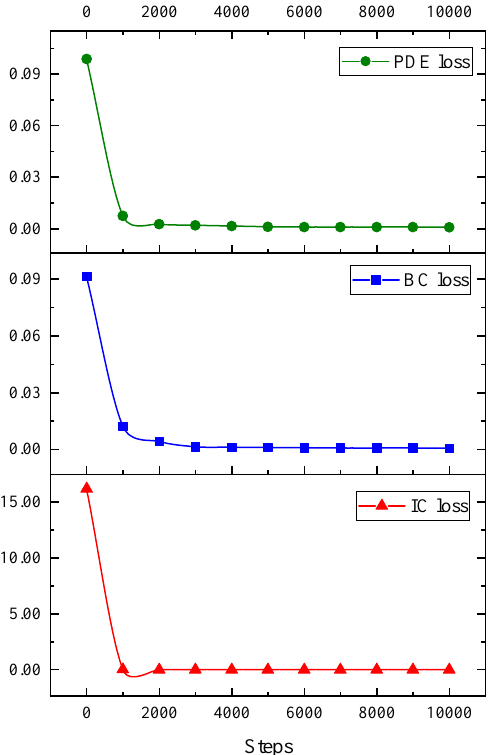
Figure 12. Testing results for two-dimensional consolidation model of drainage at the top and bottom